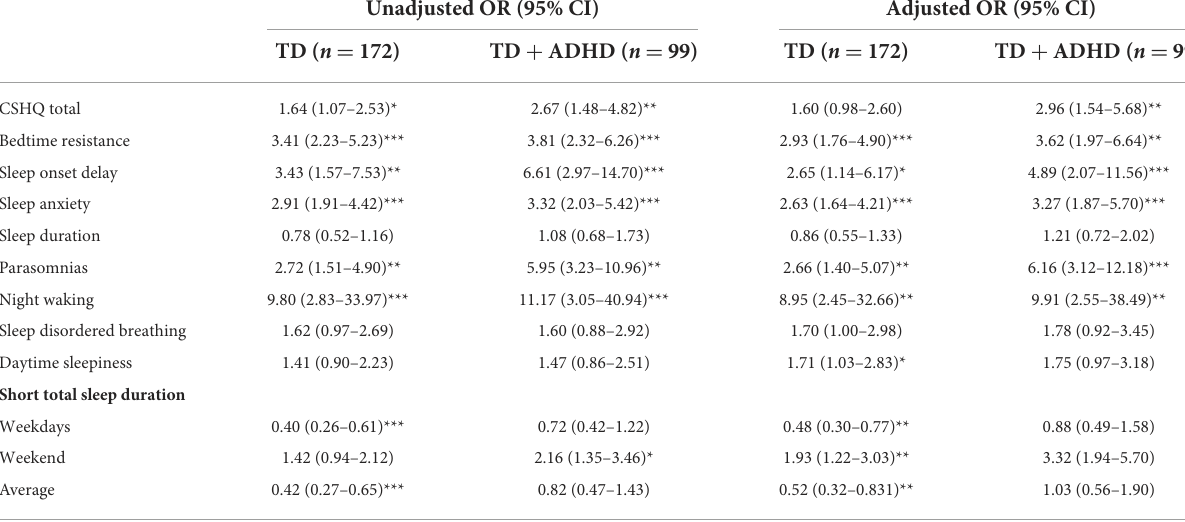
TABLE 7 The association of ADHD with sleep disturbances and short sleep duration. Unadjusted OR (95%